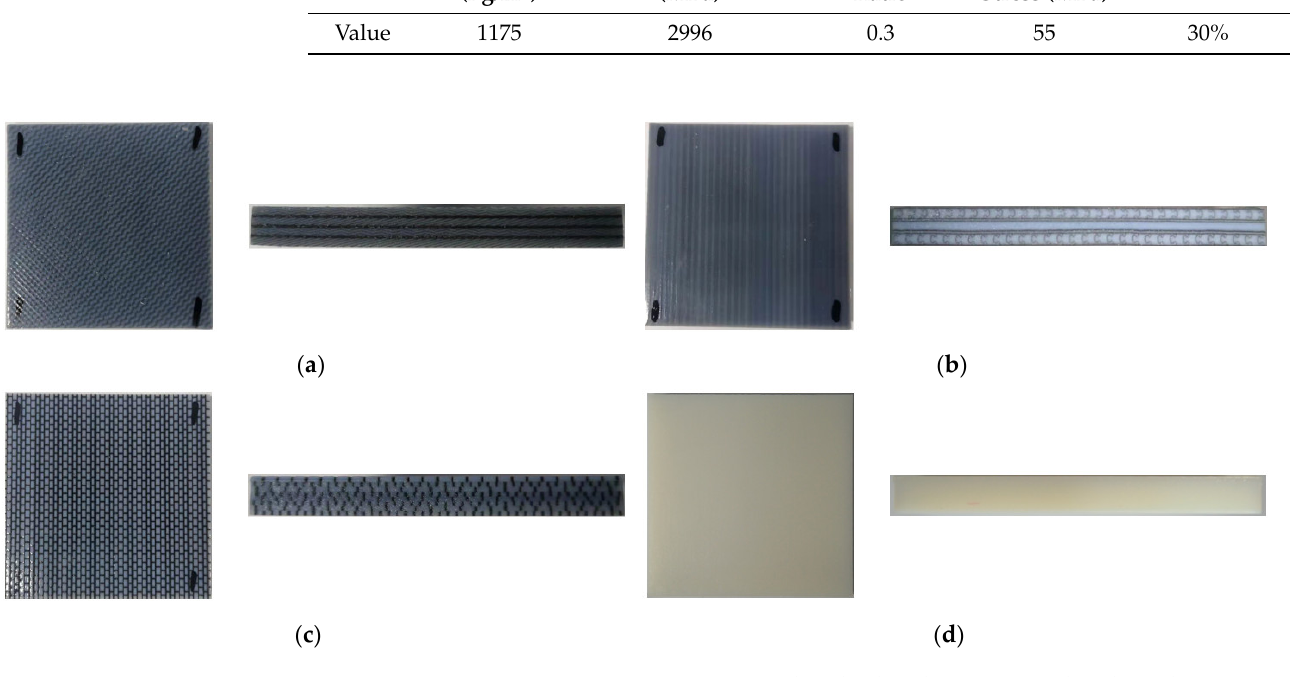
Figure 6. Tensile stress-strain curve of verowhite. Table 1. Mechanical properties parameters of verowhite.